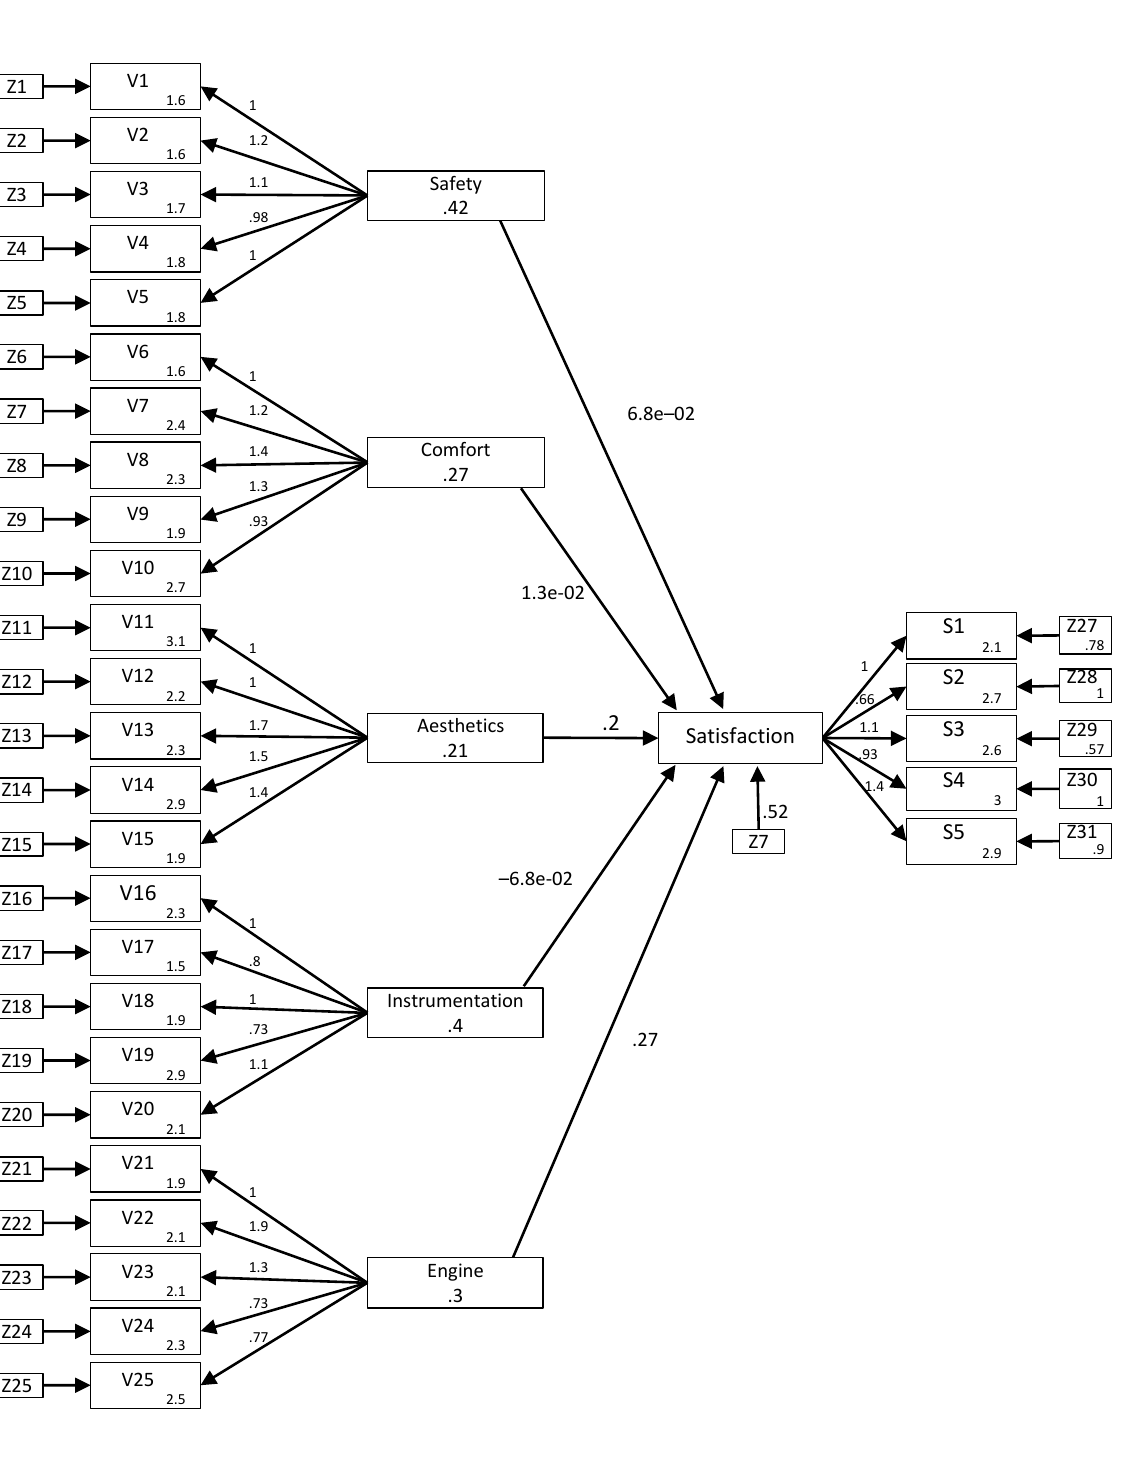
Figure 1. Structural equation